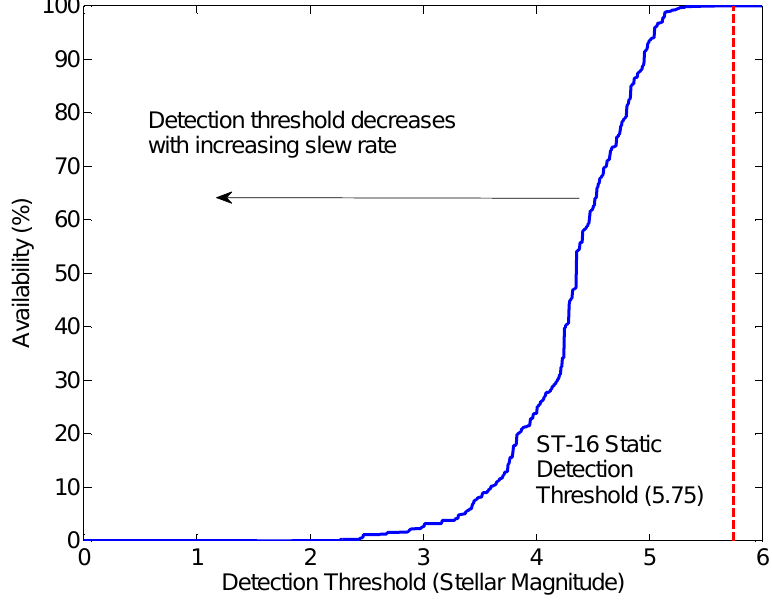
Figure 6. The ST-16 spatial static availability for varying stellar detection